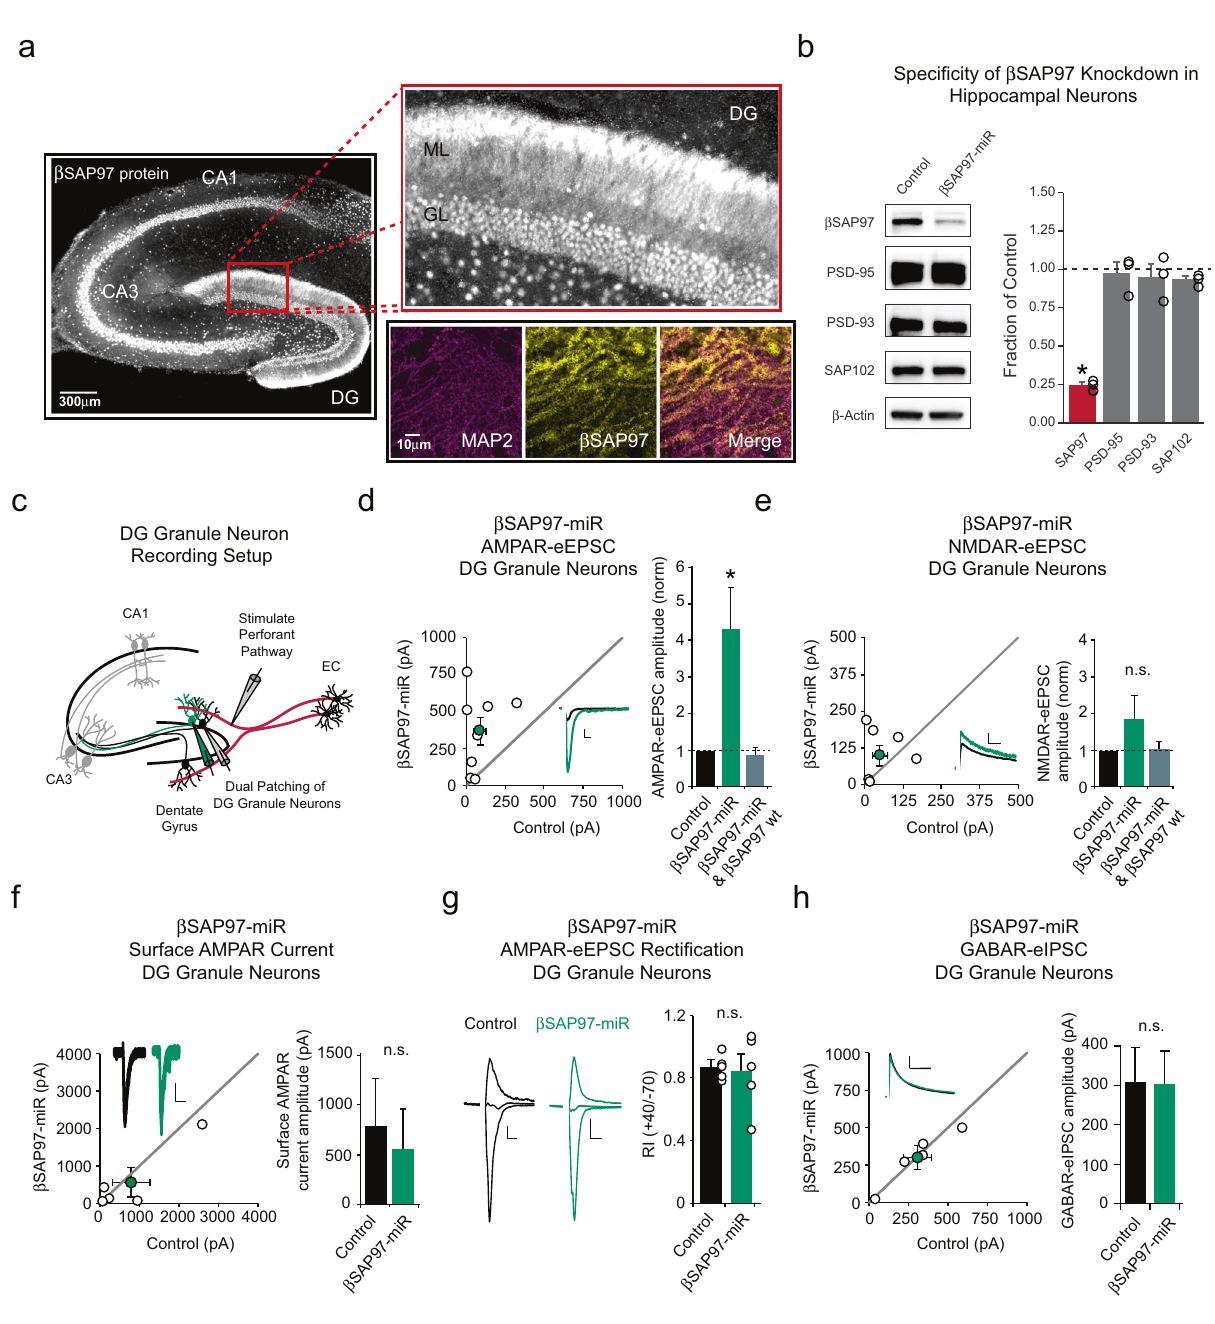
observed following β SAP97 knockdown in DG granule neurons (Fig. 1e). RT-PCR analysis con fi rmed that the increase in AMPAR-eEPSC amplitude we observed was not due to a sec- ondary upregulation of α SAP97 expression (Supplementary Fig. 2a). α SAP97 protein is not endogenously expressed in the hippocampus 24 but has been shown to augment synaptic function when exogenously expressed in neurons 61 . To further verify that the 4-fold increase in AMPAR-eESPC amplitude was indeed due to knockdown of β SAP97 speci fi cally, we generated a recombi- nant, RNAi-resistant β SAP97 expression construct (Supplemen- tary Fig. 2b). We fi rst veri fi ed that the expression of this RNAi- resistant β SAP97 was not inhibited by our β SAP97-miR (Sup- plementary Fig. 2c). Next, we co-expressed our β SAP97-miR with an mCherry-tagged RNAi-resistant β SAP97, and veri fi ed via imaging that this recombinant β SAP97 localized to